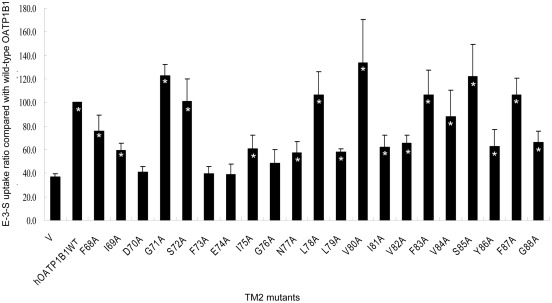
Estrone-3-sulfate uptake of OATP1B1 transmembrane domain 2 mutants.Transport of 100 nM E-3-S in HEK293 cells expressing OATP1B1 and its alanine-substituted mutants was measured. Uptake activity was expressed as a percentage of the uptake measured in wild-type. The results represent data from three experiments, with triplicate measurements for each mutant. The results shown are means ± S.E. (n = 3). Asterisks indicate values significantly different (p<0.05) from that of mock control (V).